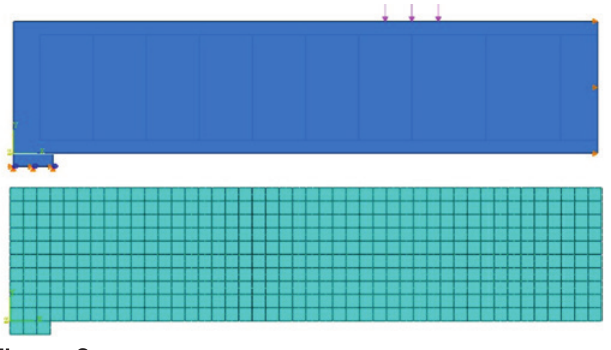
Numerical model